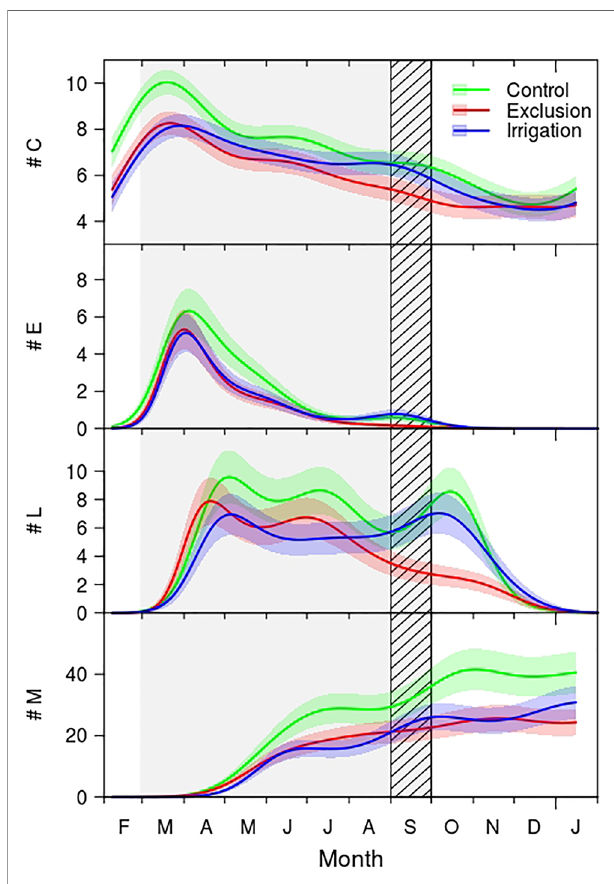
FIGURE 2 | Generalized additive mixed models (GAMMs) fi tted to the number of cambial (#C), enlargement (#E), cell wall thickening (#L), and mature cells (#M) of control (green line), exclusion (red line), and irrigation (blue line) trees. The solid lines are the fi tted curves and the shaded colored areas the 95% con fi dence interval. Difference between treatments is considered signi fi cant whenever there is no overlap between the curves con fi dence interval areas. Gray shaded area corresponds to the rain exclusion period and diagonal lines area to the irrigation period. For detailed information on the GAMM models please see Supplementary Table 1